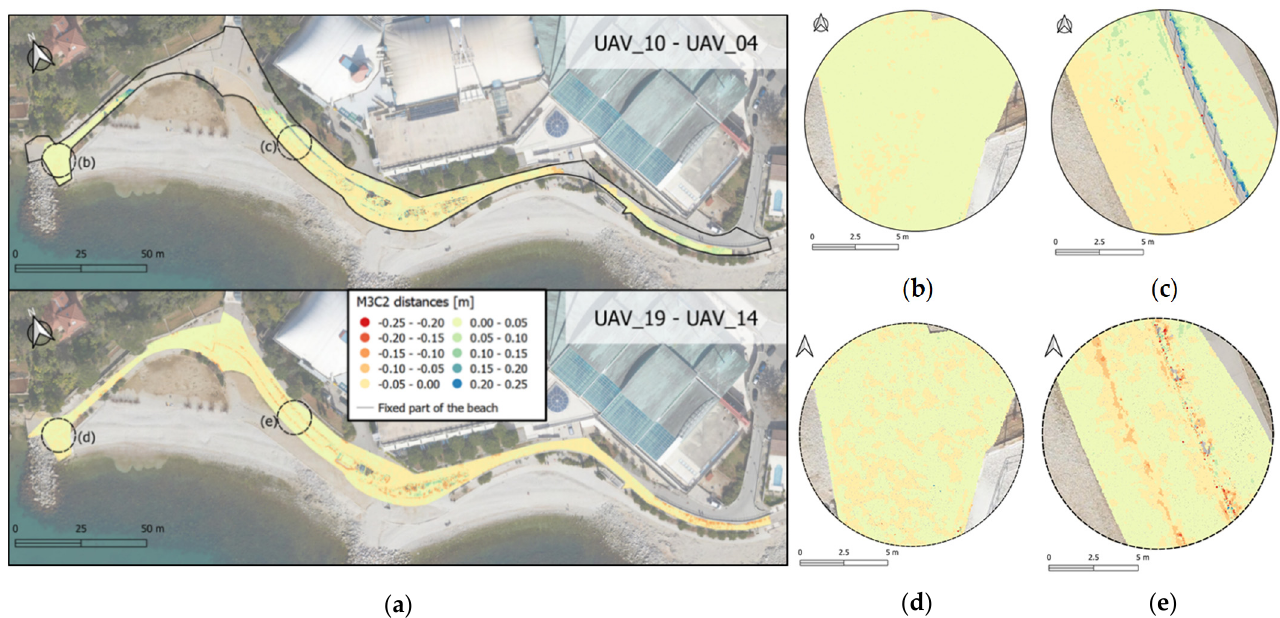
Figure 4. Vertical accuracy; ( a ) M3C2 distances on concrete promenade; ( b , c ) inserts of M3C2 from UAV_10-4; ( d , e ) inserts of M3C2 from UAV_19-14.